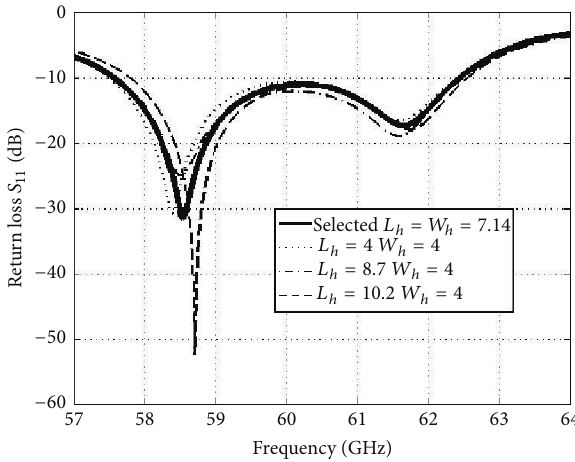
Figure 2: Varied Horn dimensions.